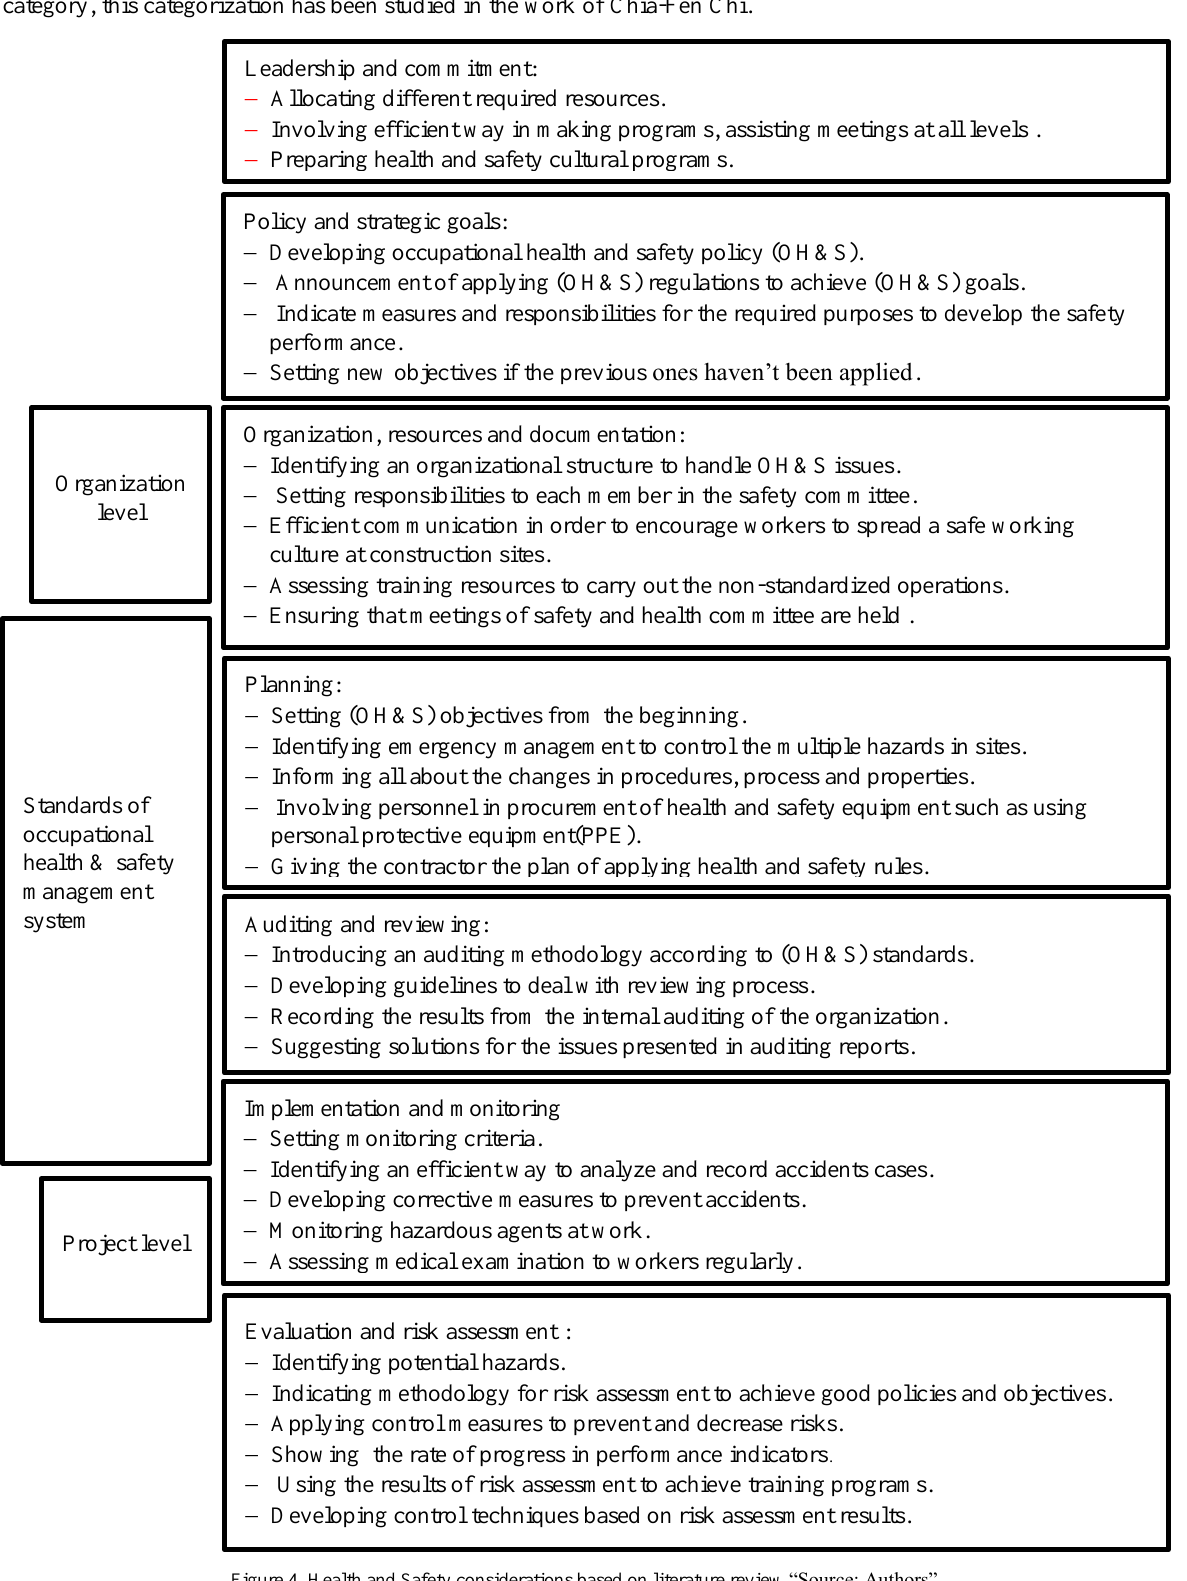
Figure 4. Health and Safety considerations based on literature review “Source: